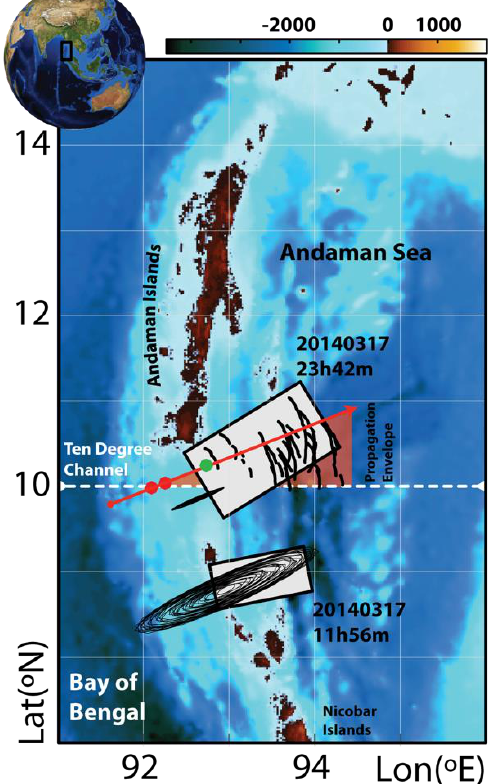
Figure 1. Bathymetry of the Andaman Sea corresponding to the inset on the top-left corner (colour-scaled on top). Grey rectangles depict subsets corresponding to TerraSAR-X acquisitions shown in Figure 3. Representative tidal ellipses are shown in black for a full spring-neap tidal cycle (the largest having a semi-major axis around 0.9 m/s). The red transect and colour-filled circles are reference locations discussed for a particular bathymetry profile shown in Figure 5.